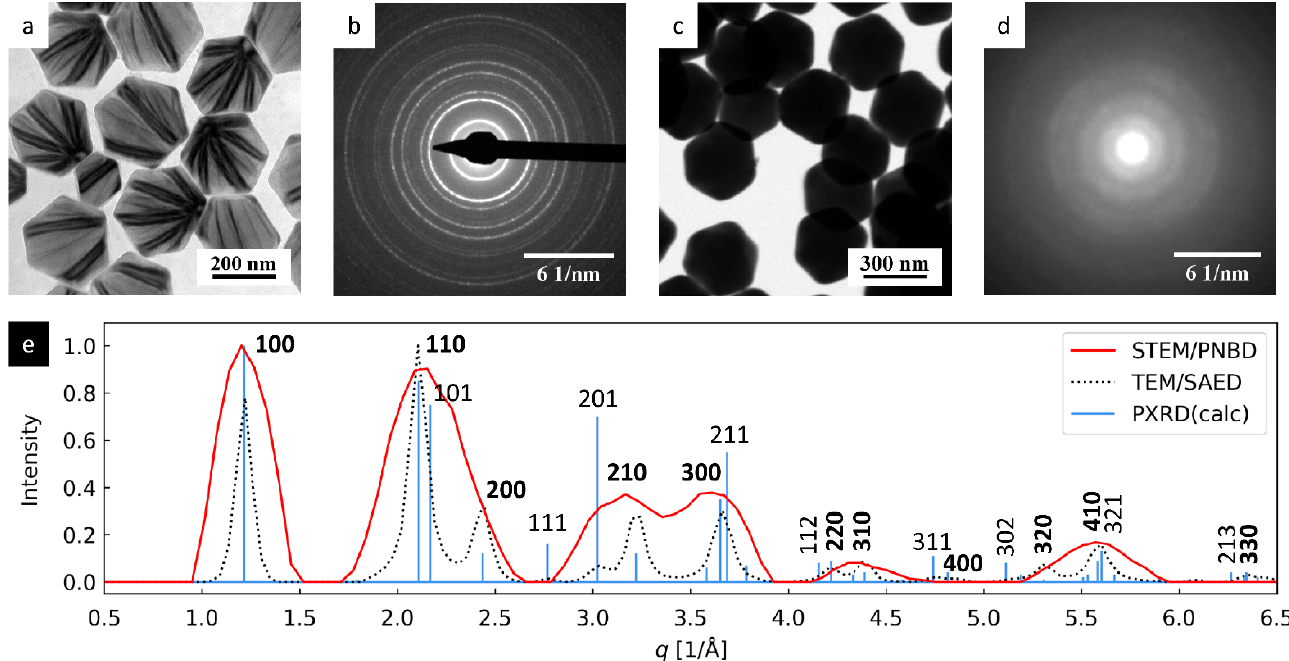
Figure 5. 4D-STEM/PNBD results for NaYF 4 nanocrystals and their comparison with TEM and PXRD results: ( a ) TEM/BF image, ( b ) TEM/SAED diffraction pattern, ( c ) STEM/BF image, ( d ) 4D-STEM/PNBD diffraction pattern, and ( e ) comparison of radially averaged results from 4D-STEM/PNBD (red line), TEM/SAED (black dotted line), and theoretically calculated PXRD diffraction pattern of NaYF 4 . The hk0 diffraction peaks, which were stronger in TEM/SAED and 4D-STEM/PNBD than in PXRD due to preferred orientation of nanocrystals, are marked with bold font.